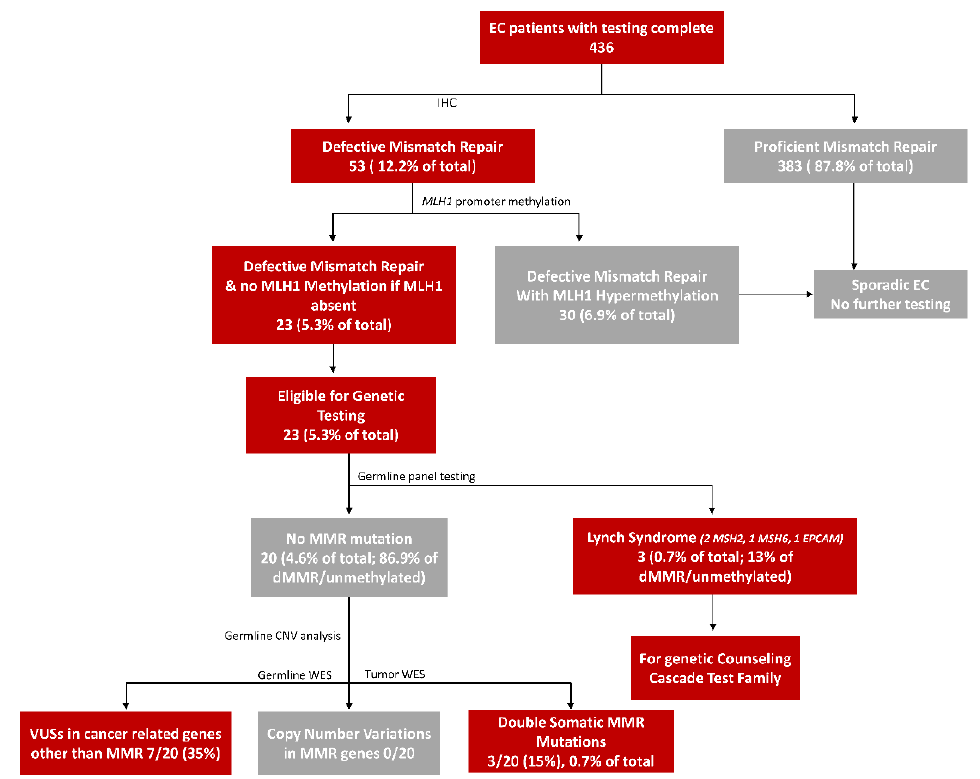
Figure 1. Endometrial cancer study schema.